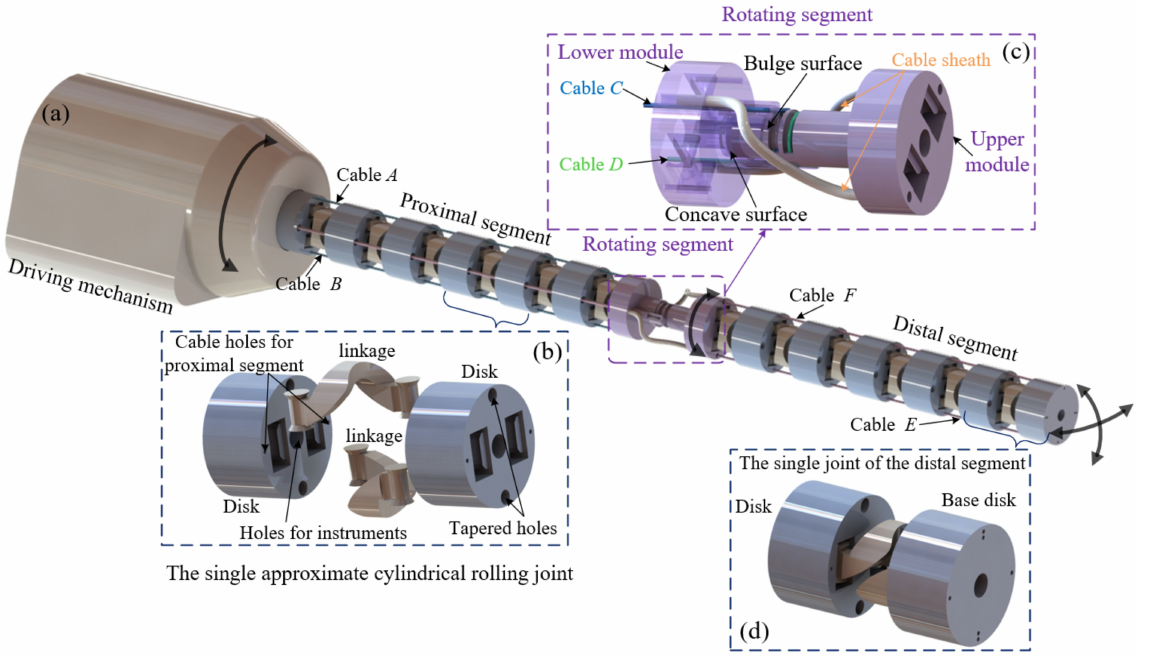
Figure 7. The CAD model of the cable-driven snake-arm robot. ( a ) The cable-driven snake-arm robot model. ( b ) The joint in the proximal segment. ( c ) The structure of the rotating segment. ( d ) The joint in the distal